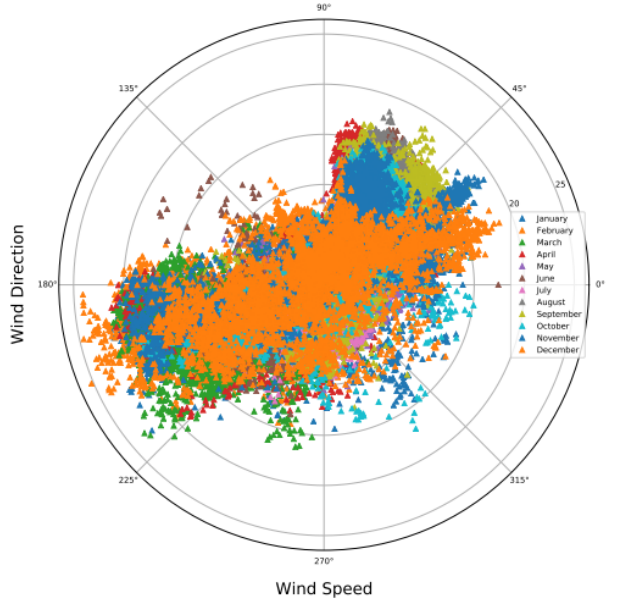
Figure 6. Wind turbine Scada dataset 2D visualization in polar